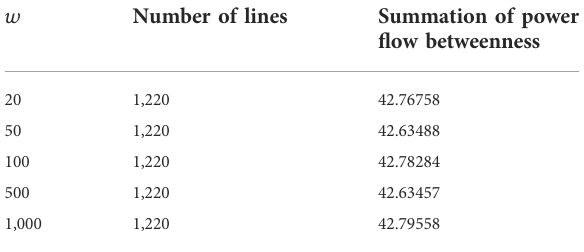
TABLE 5 Number of branches and summation of branch betweenness for backbone grid of the French 1888 bus system with different w w